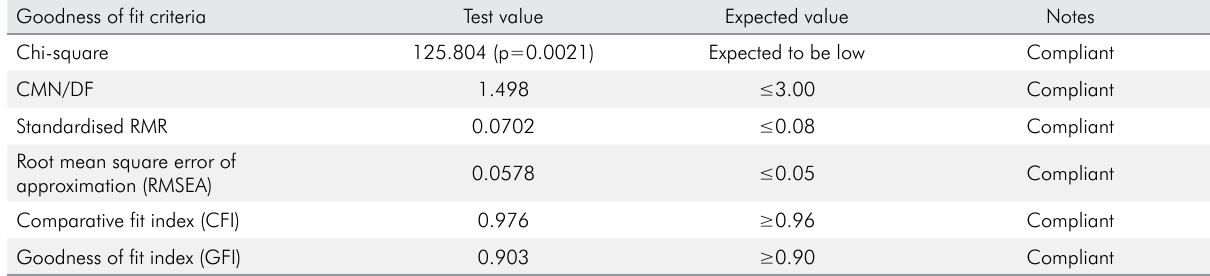
Table 6. Testing results for the DTMS modification model